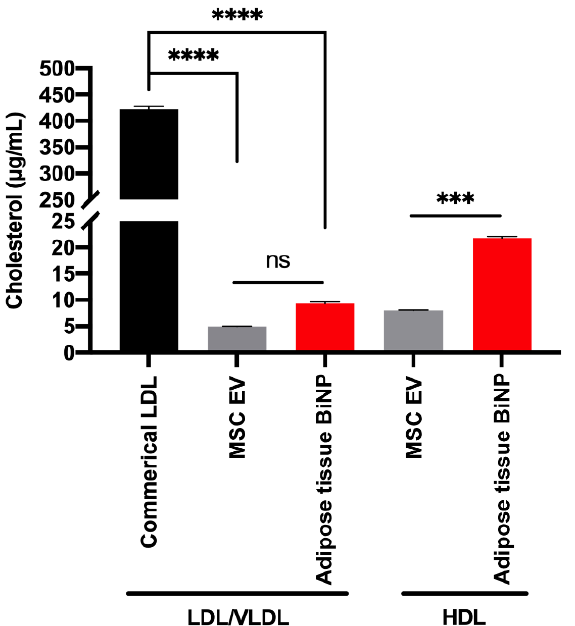
Figure 3. Cholesterol concentration associated with low-density lipoprotein (LDL) and very-low- density lipoprotein (VLDL) or high-density lipoprotein (HDL) in EV/BiNP samples. Commercial LDL at a concentration of 500 µg/mL apolipoprotein B-100 (ApoB-100) was used as a positive control (1000 µg/mL of ApoB-100 is the upper limit in the plasma of healthy individuals). Data are presented as mean ± standard deviation (SD) of three replicates. Statistics by analysis of variance (ANOVA) with Tukey’s multiple comparison post-hoc analysis. ***, p < 0.001; ****, p < 0001. ns, not significant.